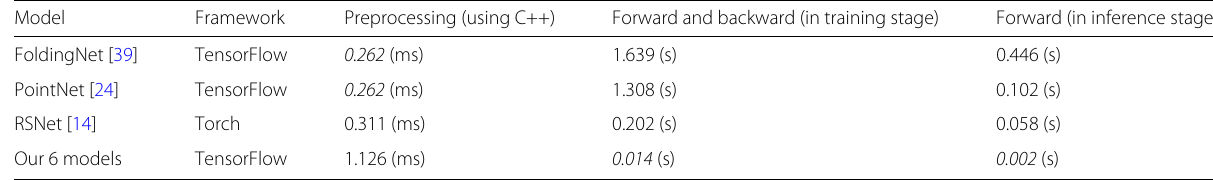
Table 4 Average processing time of basic operations in experimented models